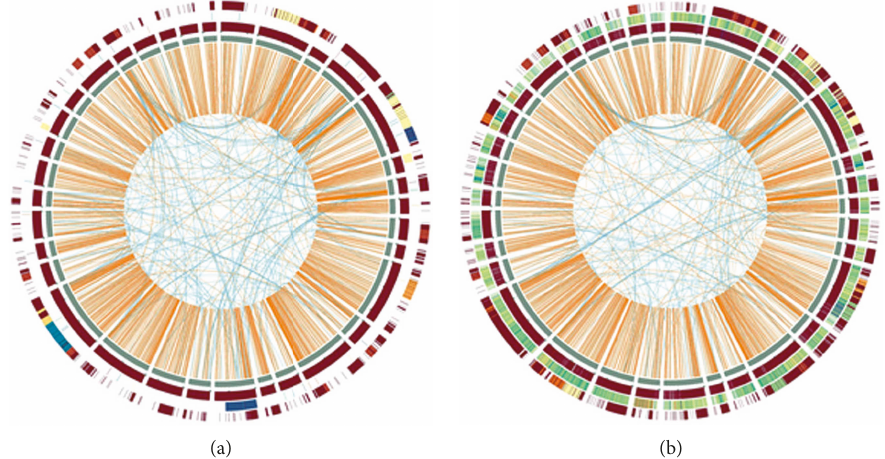
Figure 3: Genome-wide landscape of structural variations of greater amberjack. We linked the BreakDancer data to Circus plots to visualize regions of the genome that contained structural variations. We combined the resequenced data of (a) eight greater amberjacks captured o ff the Kochi coast and (b) 12 greater amberjacks captured o ff the Chinese Hainan Islands coast and analyzed these data by BreakDancer. Gene density of each contig is visualized by dark lines. The outermost circle shows inversion, next circle shows insertion, and third circle shows deletion. Orange lines show intrachromosomal translocations, and blue lines show interchromosomal translocations.